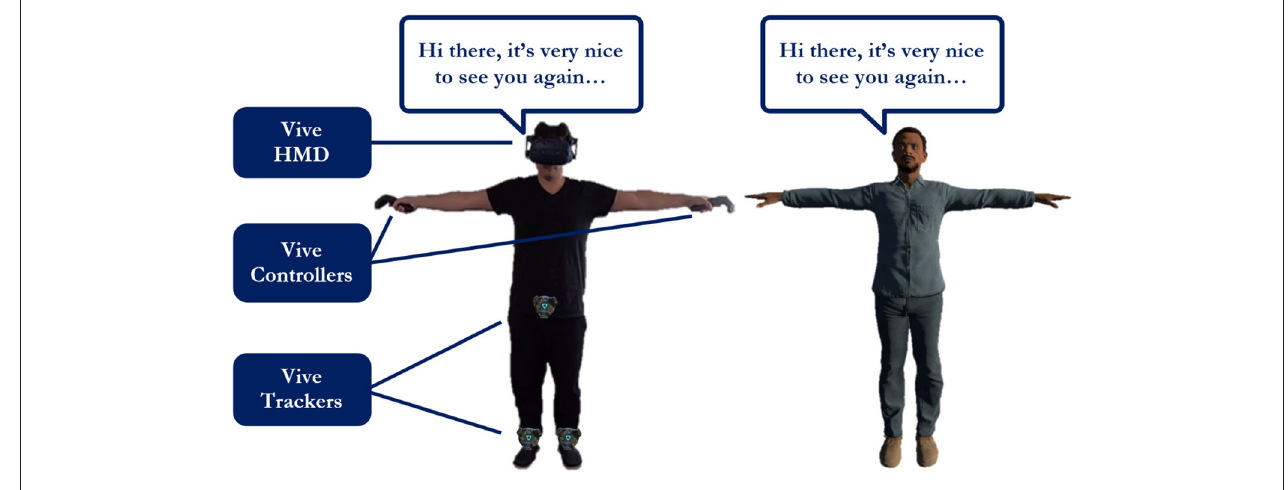
FIGURE 4 | Virtual human animation set